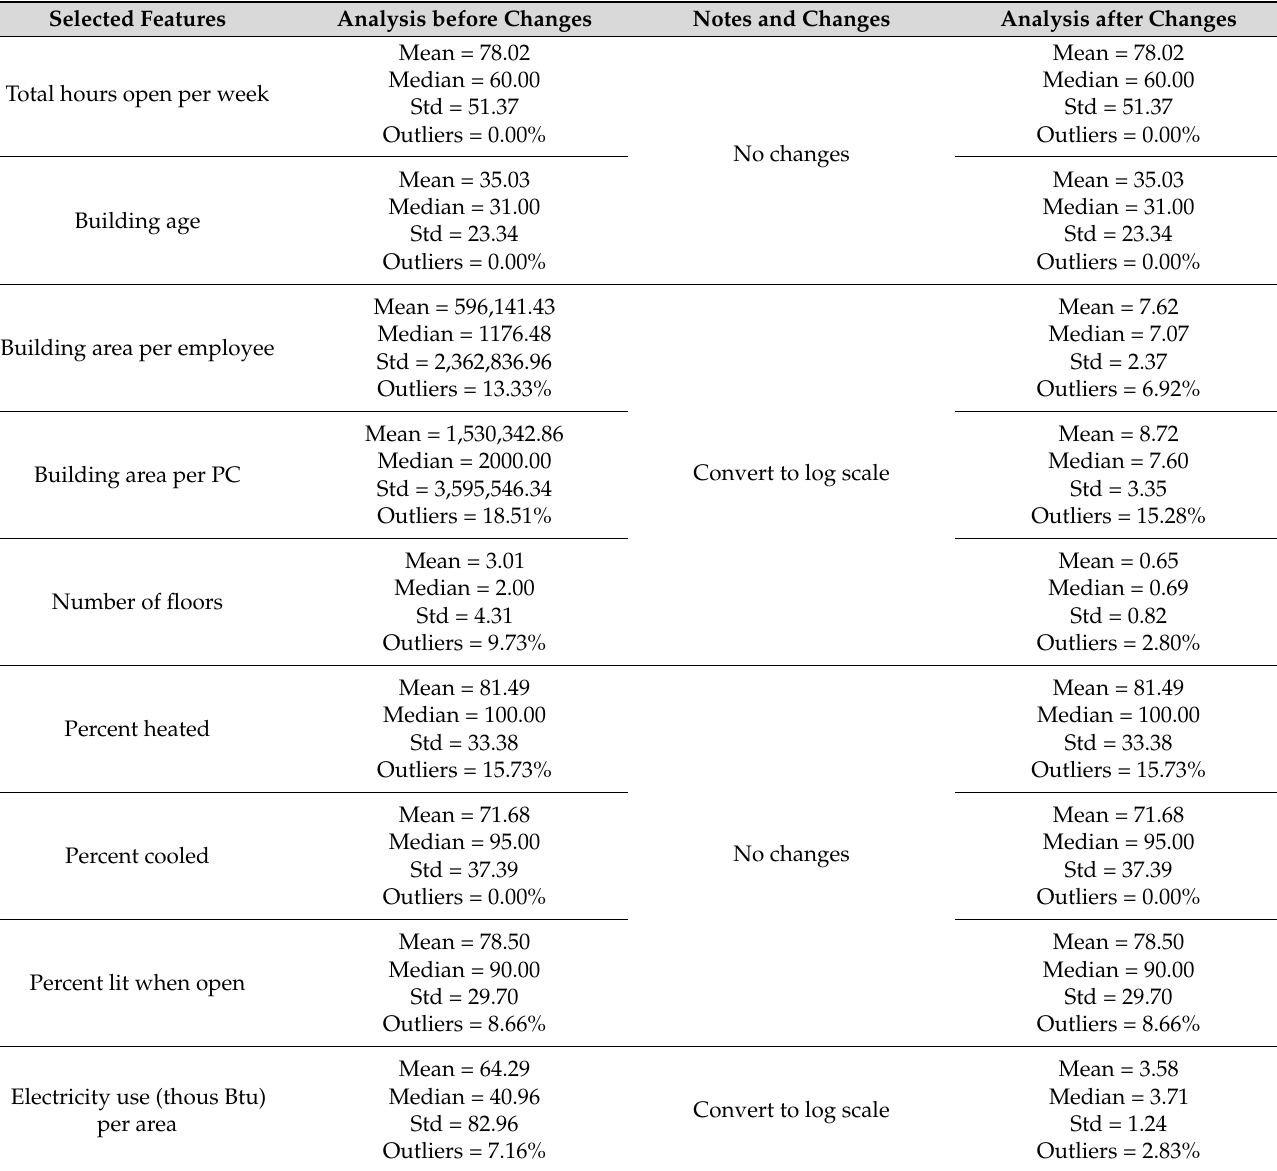
Table 4. The final features of the ML